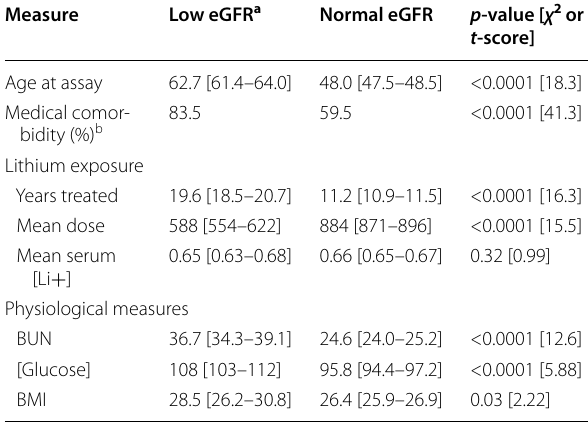
Table 5 Measures associated with vs. without low eGFR among 2669 assays in 312 bipolar disorder subjects treated long-term with